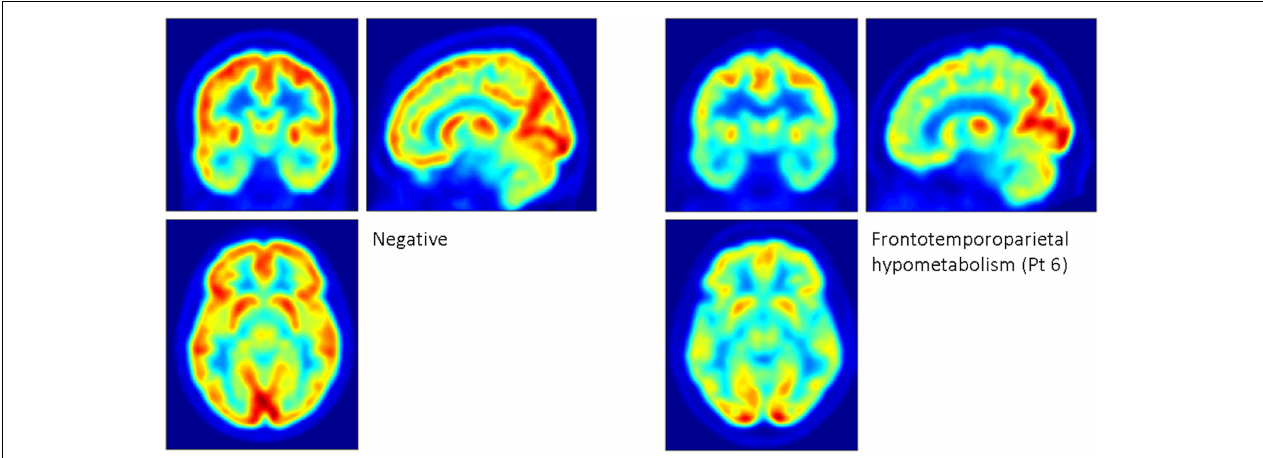
FIGURE 1 | Examples of patterns of glucose metabolism revealed by [ 18 F]FDG PET. The panel on the left depicts the mean of two patients who had scans that were reported as normal. The panel on the right depicts marked, widespread frontotemporoparietal hypometabolism sparing the occipital cortex, seen in patient 6, a 40-year-old male with full-scale IQ of 90 who ceased adherence to the low phenylalanine diet before he reached 10 years of age. His most recent blood spot phenylalanine measurement prior to the scan was 1200 µ mol/ml. Based on 25 phenylalanine and 22 tyrosine measurements, his mean ± standard deviation historical phenylalanine was 877.2 ± 183.6 µ mol/ml, and his Phe:Tyr ratio was 89.2 ± 52.6. TABLE 2 | Clusters of negative correlation between SUV and Phe, between SUV and Phe:Tyr, and between SUV and SD-Phe:Tyr. SUV-Phe Peak